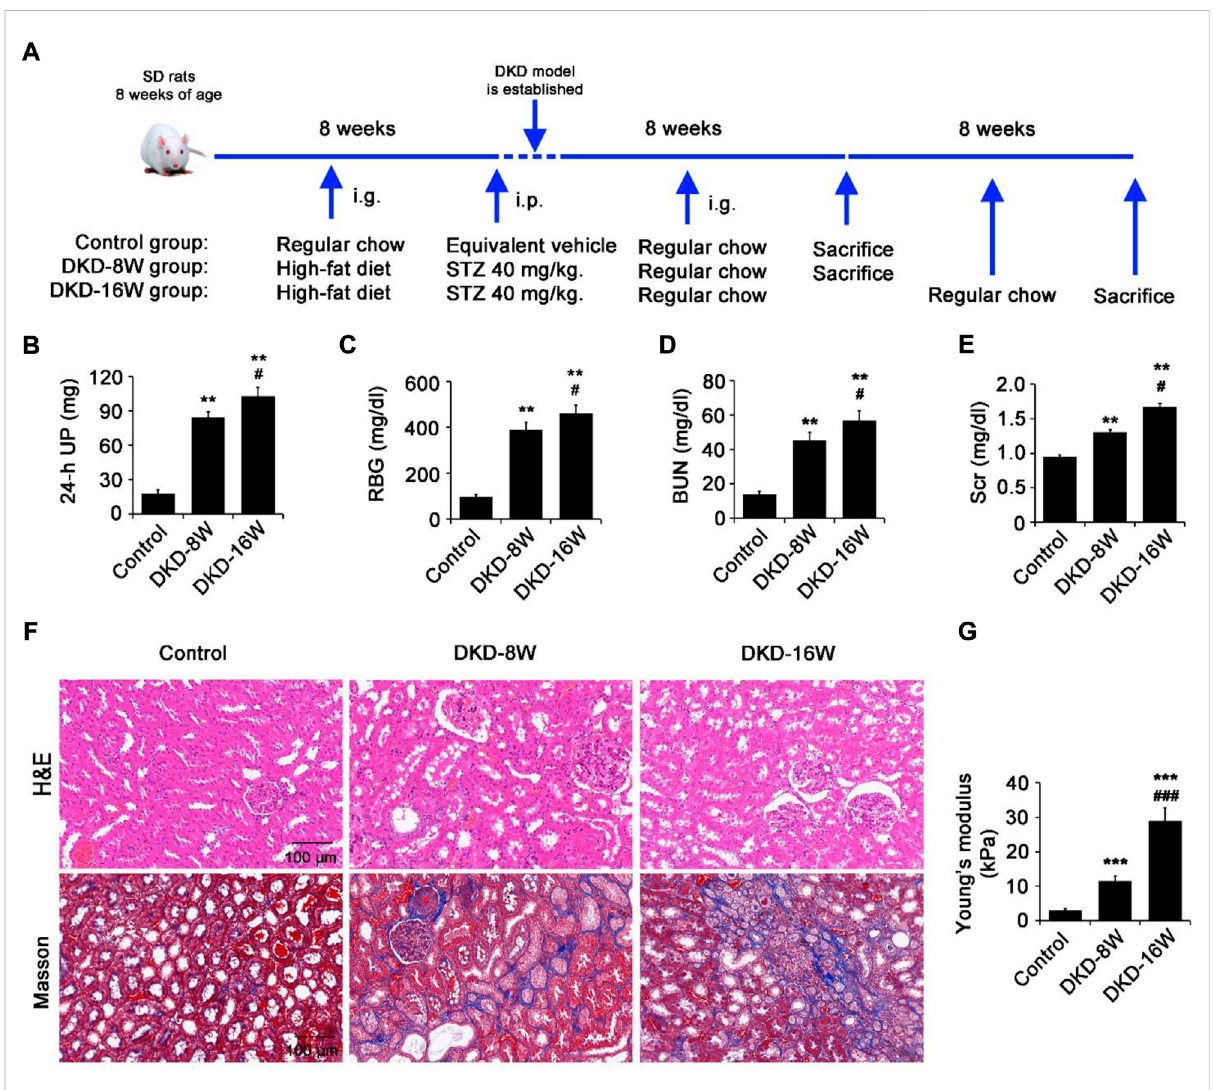
The kidney stiffness of DKD rats increased with the aggravation of renal fi brosis. (A) SD rats were fed with a high-fat diet for 8 weeks, and then injected with 40 mg/kg STZ intraperitoneally to establish the DKD rat model. (B – E) The 24 h-UP (B) , RBG (C) , BUN (D) and Scr (E) were measured at the 8th (DKD-8W) and 16th (DKD-16W) weeks after successful DKD modeling. (F) Histopathology analysis of the kidneys in DKD-8W and DKD-16W ratswasperformedbyhematoxylin-eosin (H&E)stainingand massonstaining. (G) Using acantilever-basednanointender,theYoung ’ sModulus of cryostat sections of the kidneys in normal, DKD-8W and DKD-16W rats were assessed. STZ, streptozocin; UP, urine protein; RBG, random blood glucose; BUN: blood urea nitrogen; Scr: serum creatinine; DKD, diabetic kidney disease; DKD-8W and DKD-16W, 8 and 16 weeks after